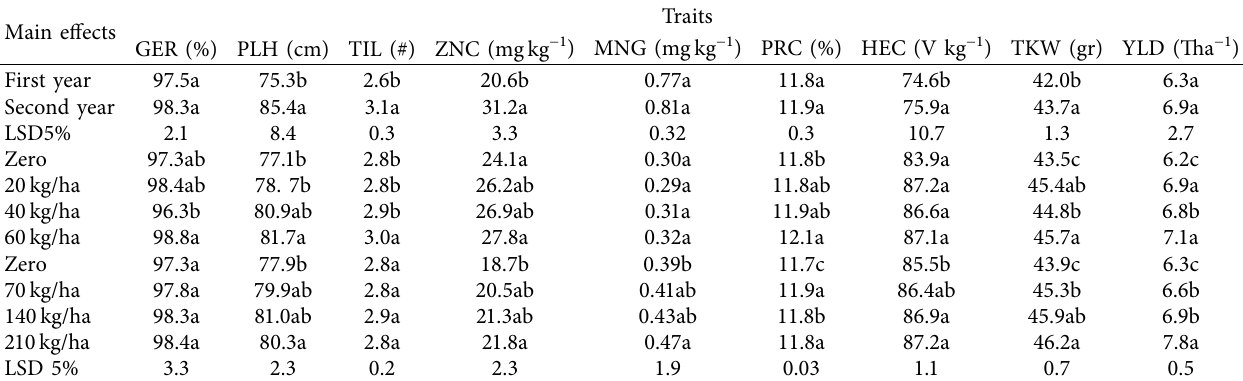
Table 2: Comparison of the traits measured in the examination of different levels of zinc and magnesium in bread wheat based on combined